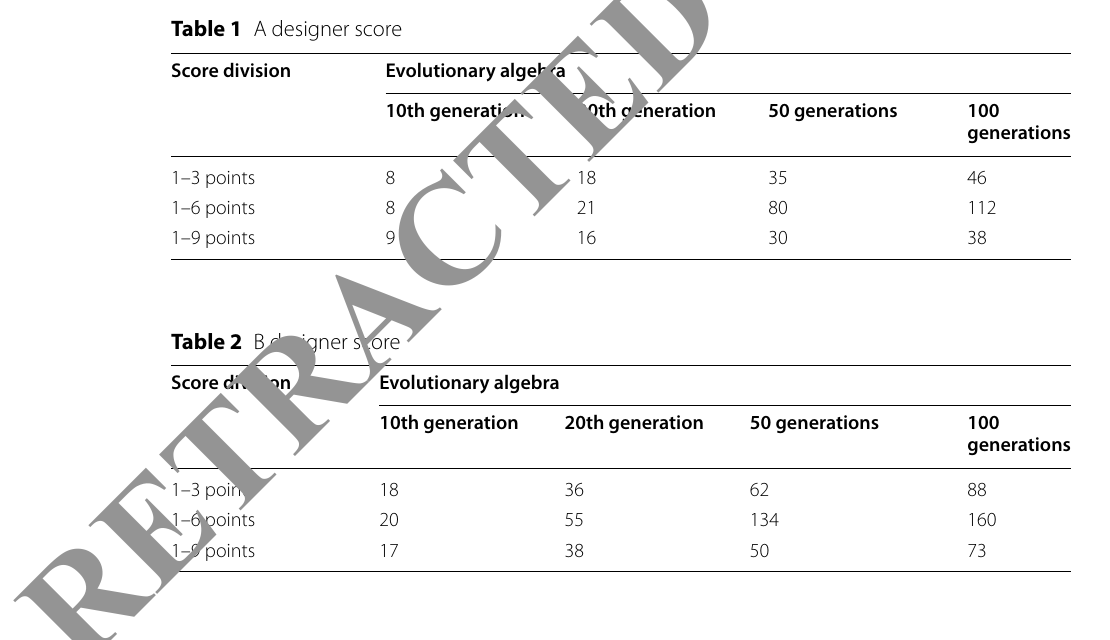
Score division Evolutionary algebra